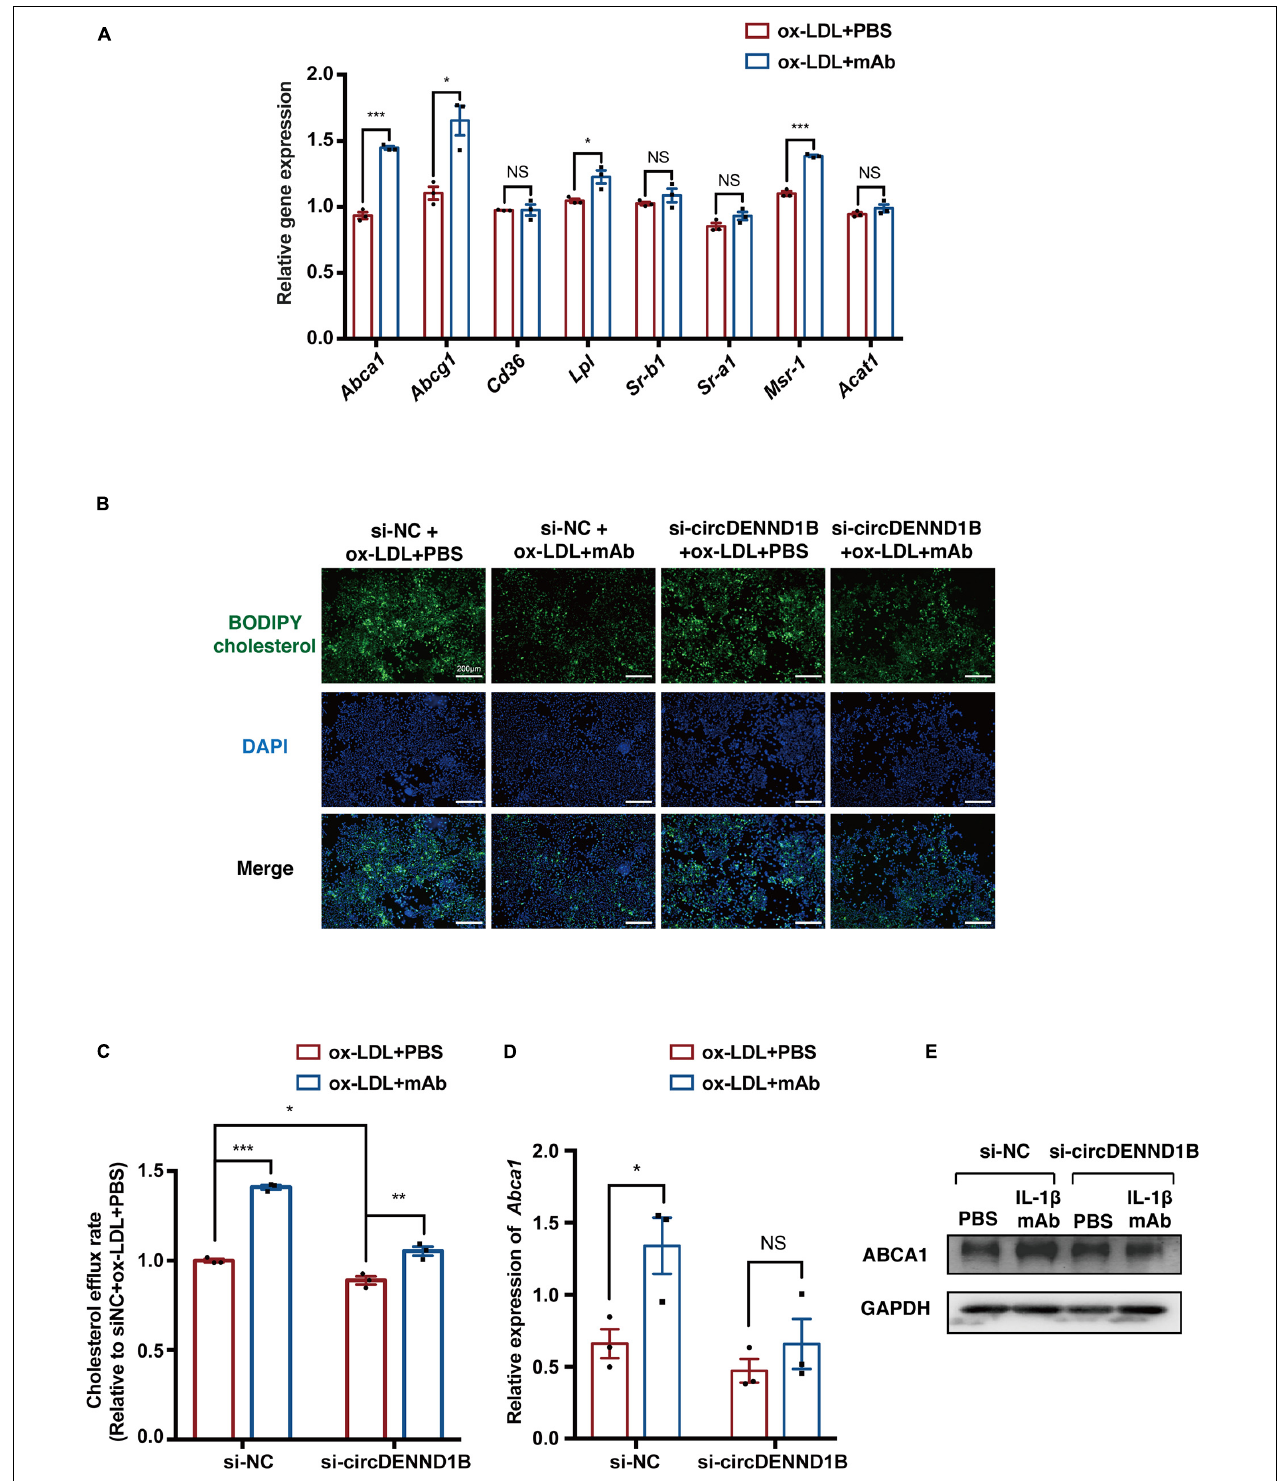
FIGURE 4 | circDENND1B is crucial in the pro-cholesterol efflux effect of IL-1 β mAb in vitro. (A) qRT-PCR results of genes related to foam cell formation in IL-1 β mAb-treated foam cells. (B) Representative images of BODIPY assay showing circDENND1B mediates the pro-cholesterol efflux effect of IL-1 β mAb. (C) Relative cholesterol efflux rate in RAW264.7 cells, measured by BODIPY assay ( n = 3 per group). (D) qRT-PCR results of Abca1 expression in si-circDENND1B-treated cells, data were normalized to GAPDH data ( n = 3 per group) (E) WB results of ABCA1 in cells transfected with si-circDENND1B and treated with ox-LDL plus PBS or IL-1 β